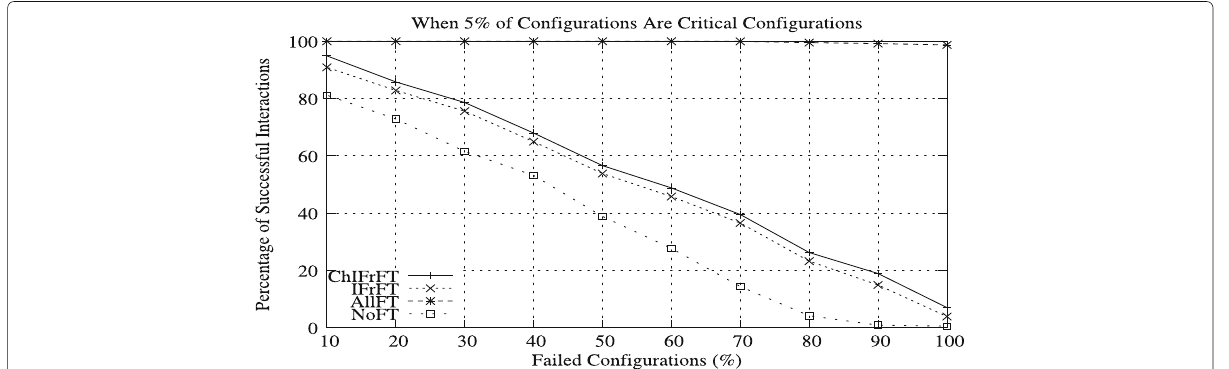
Fig. 9 Critical configurations are 5% of all configurations